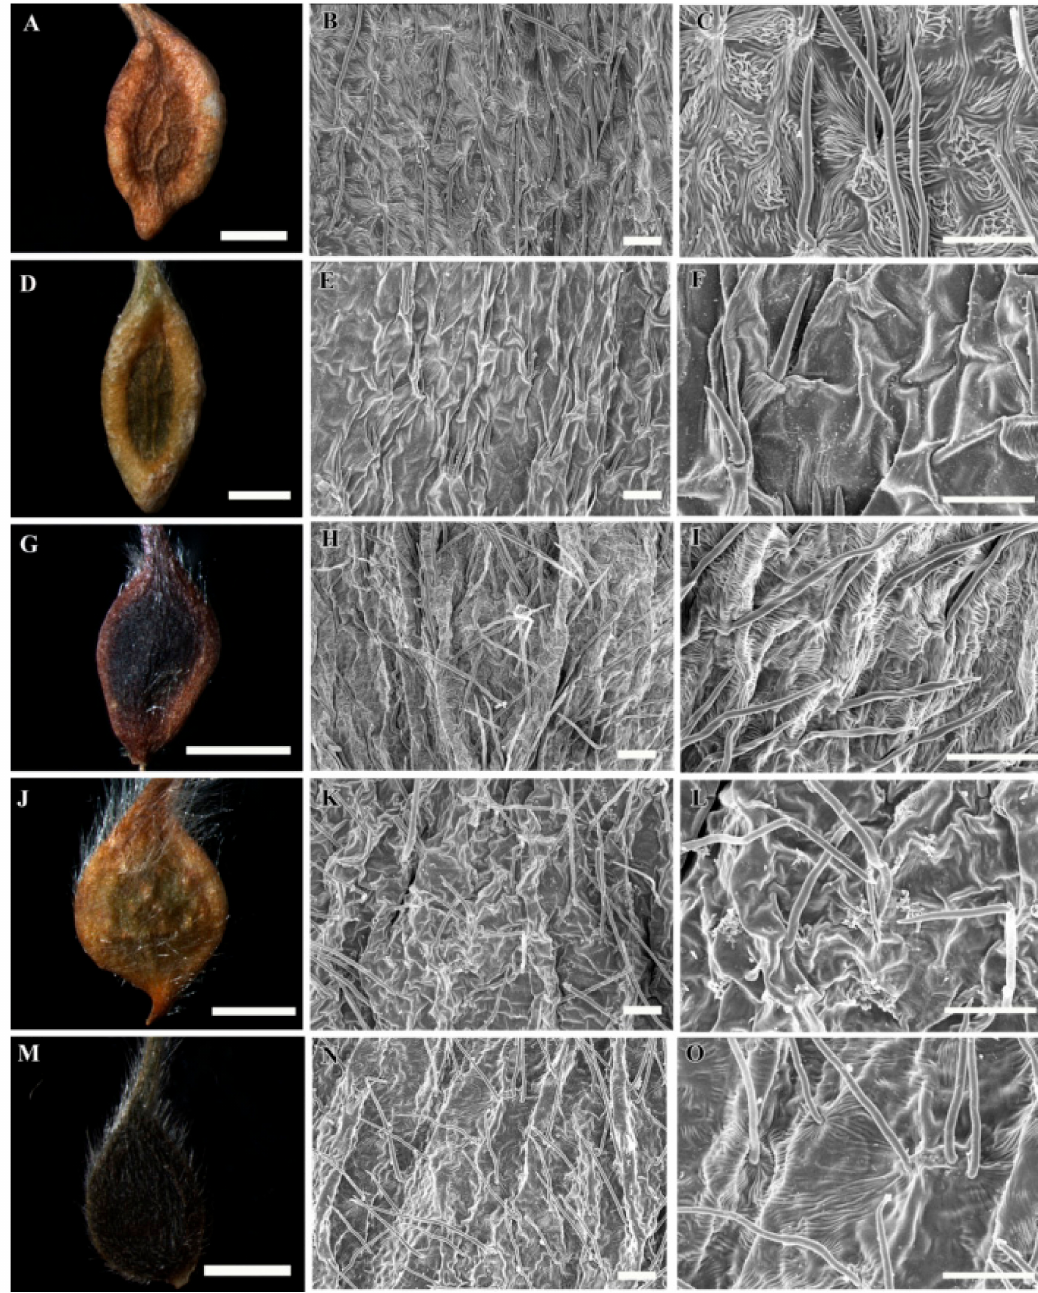
Figure 2. Stereomicroscopic and scanning electron microscopic micrographs of achenes of Clematis